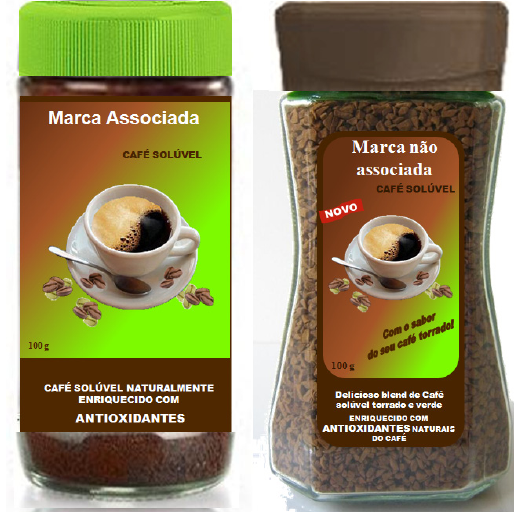
Figure 1. Examples of stimulus profiles used in the conjoint